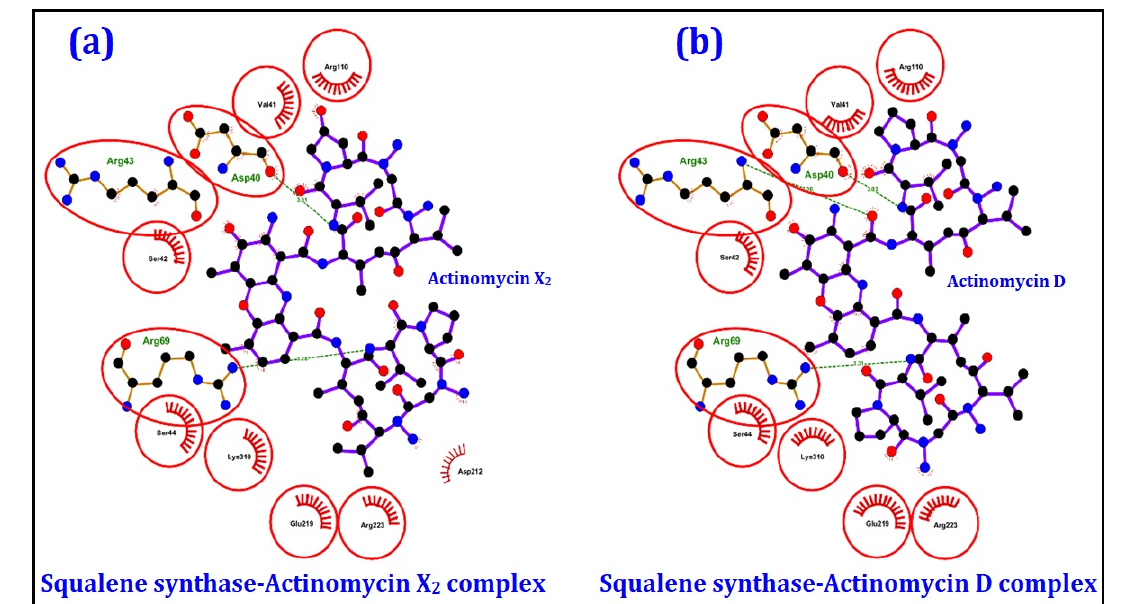
Figure 6. 2D interactions analyses of the squalene synthase complexed with ( a ) actinomycin X 2 and ( b ) actinomycin D, obtained from the molecular docking exercises. The AAs residues interacting with the ligand are shown in red circles.